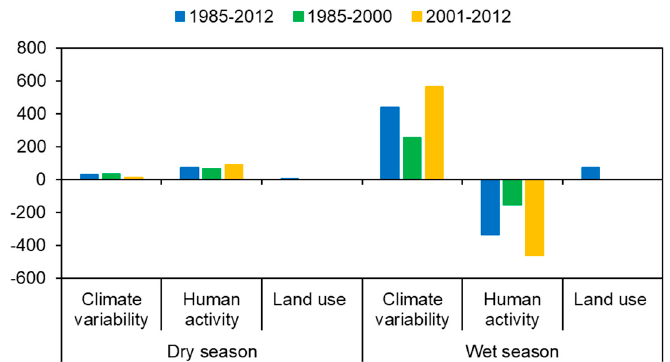
Figure 8. Contributions of climate variability, human activity, and land-use change to runoff variation on the seasonal scale over three different periods (1985–2012, 1985–2000, and 2001–2012) for the Qingliu River basin, East China.